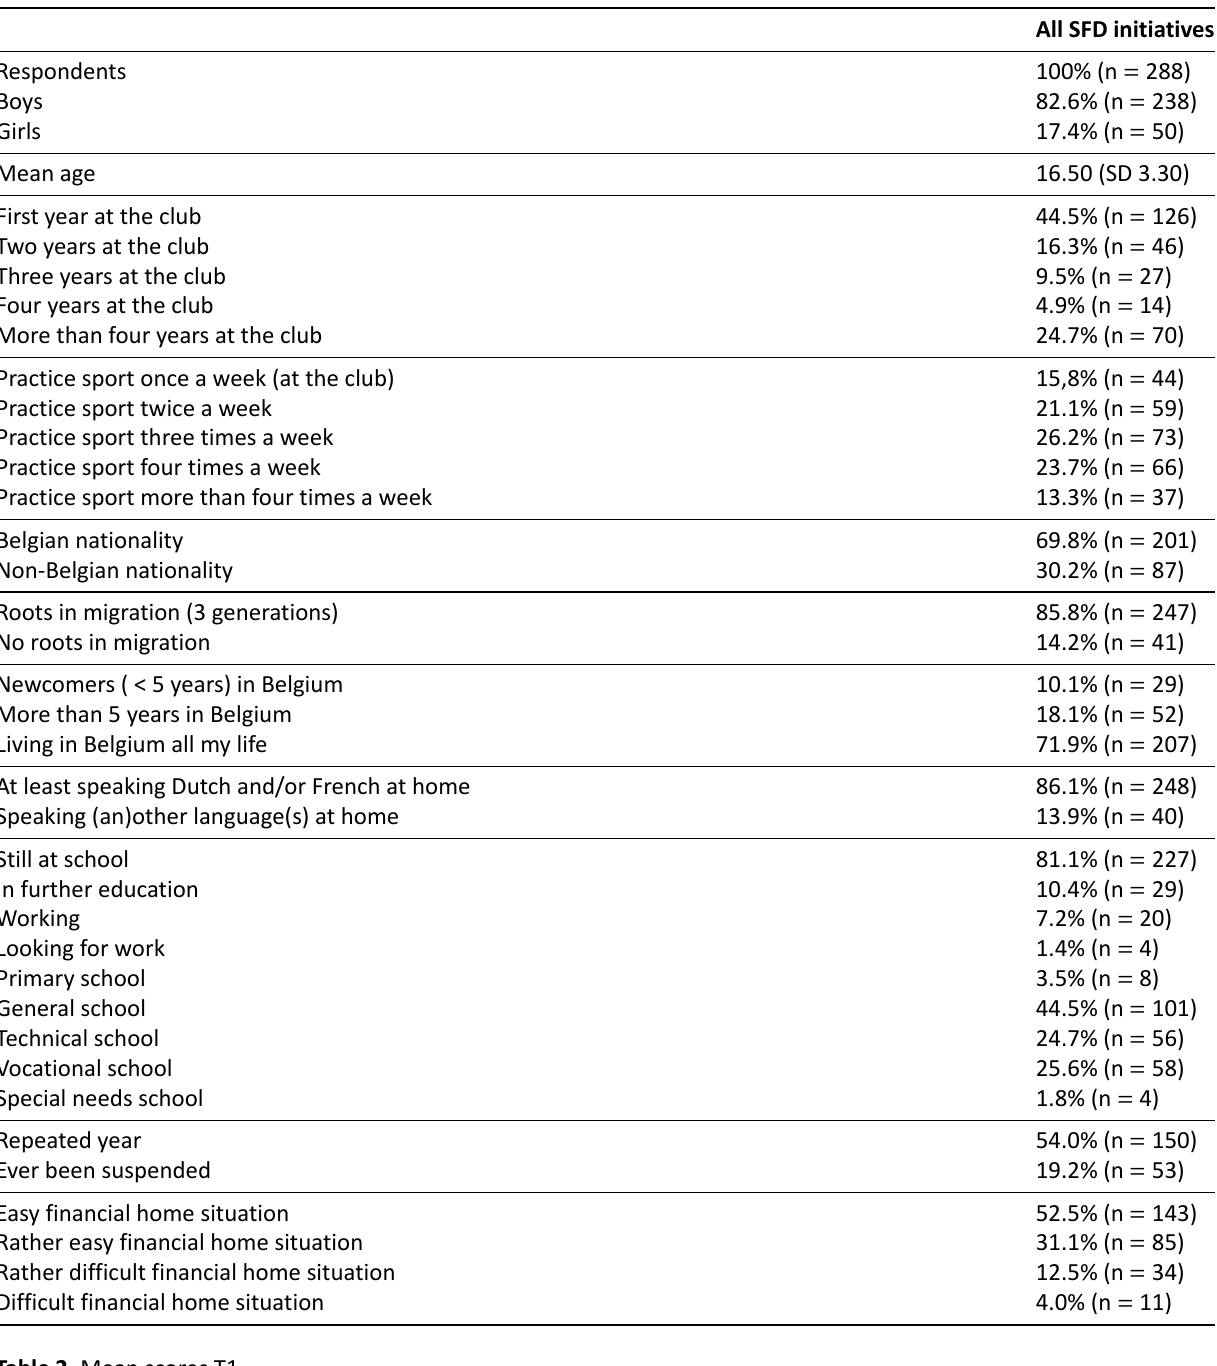
Table 1. Participants’ characteristics and proxy-indicators of social vulnerability.